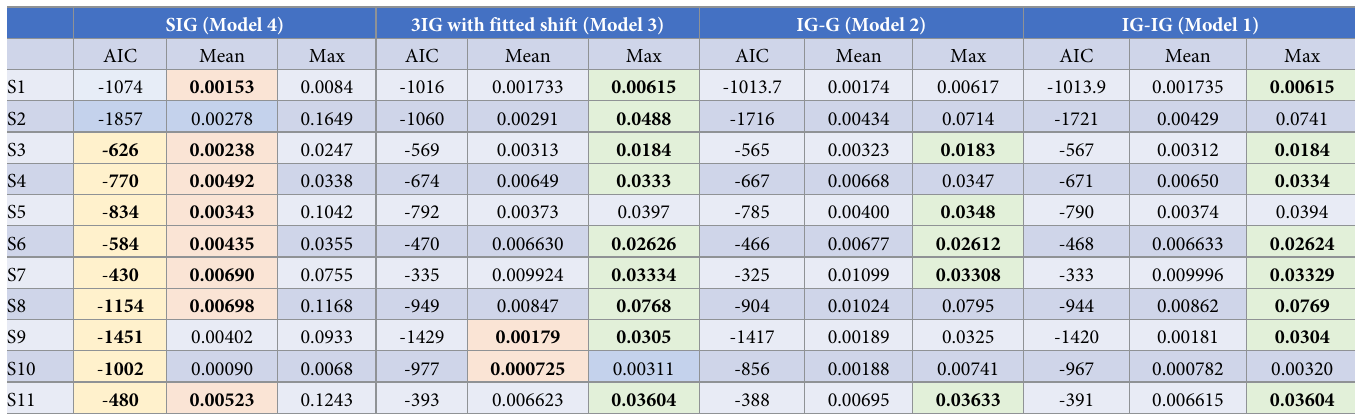
Table 2. Model fit results for awake and at rest cohort for Models 1–4.